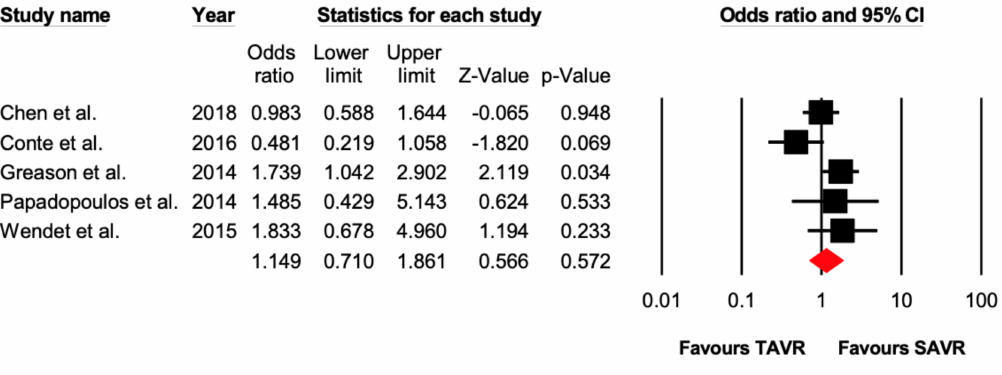
Figure 3. Forest plot comparing the risk of 1–2-year all-cause mortality between transcatheter versus surgical aortic valve